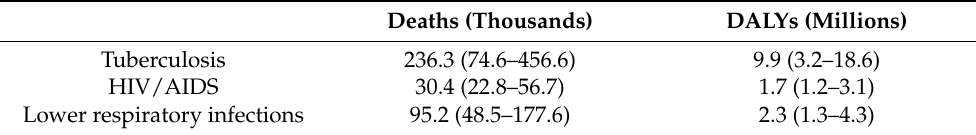
Table 1. Alcohol-attributable communicable diseases: 2016 estimates